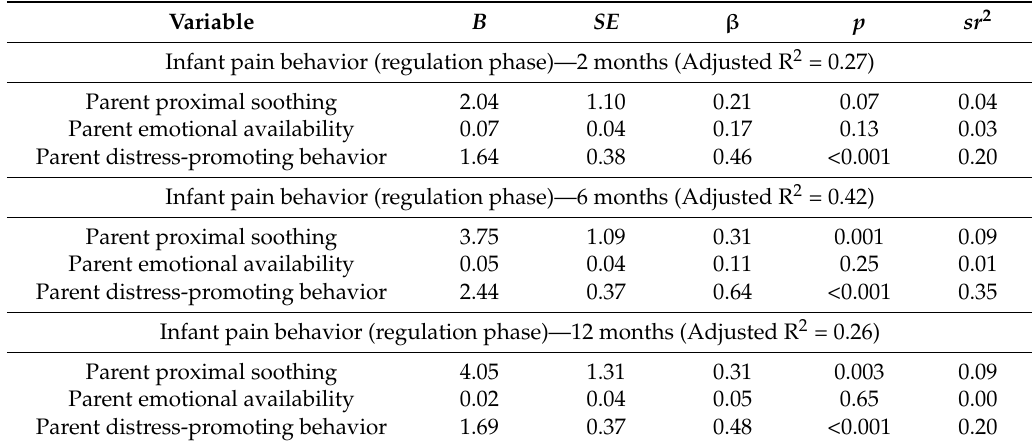
Table 4. Summary of multiple regression analysis for infant pain behavior during the regulation phase.